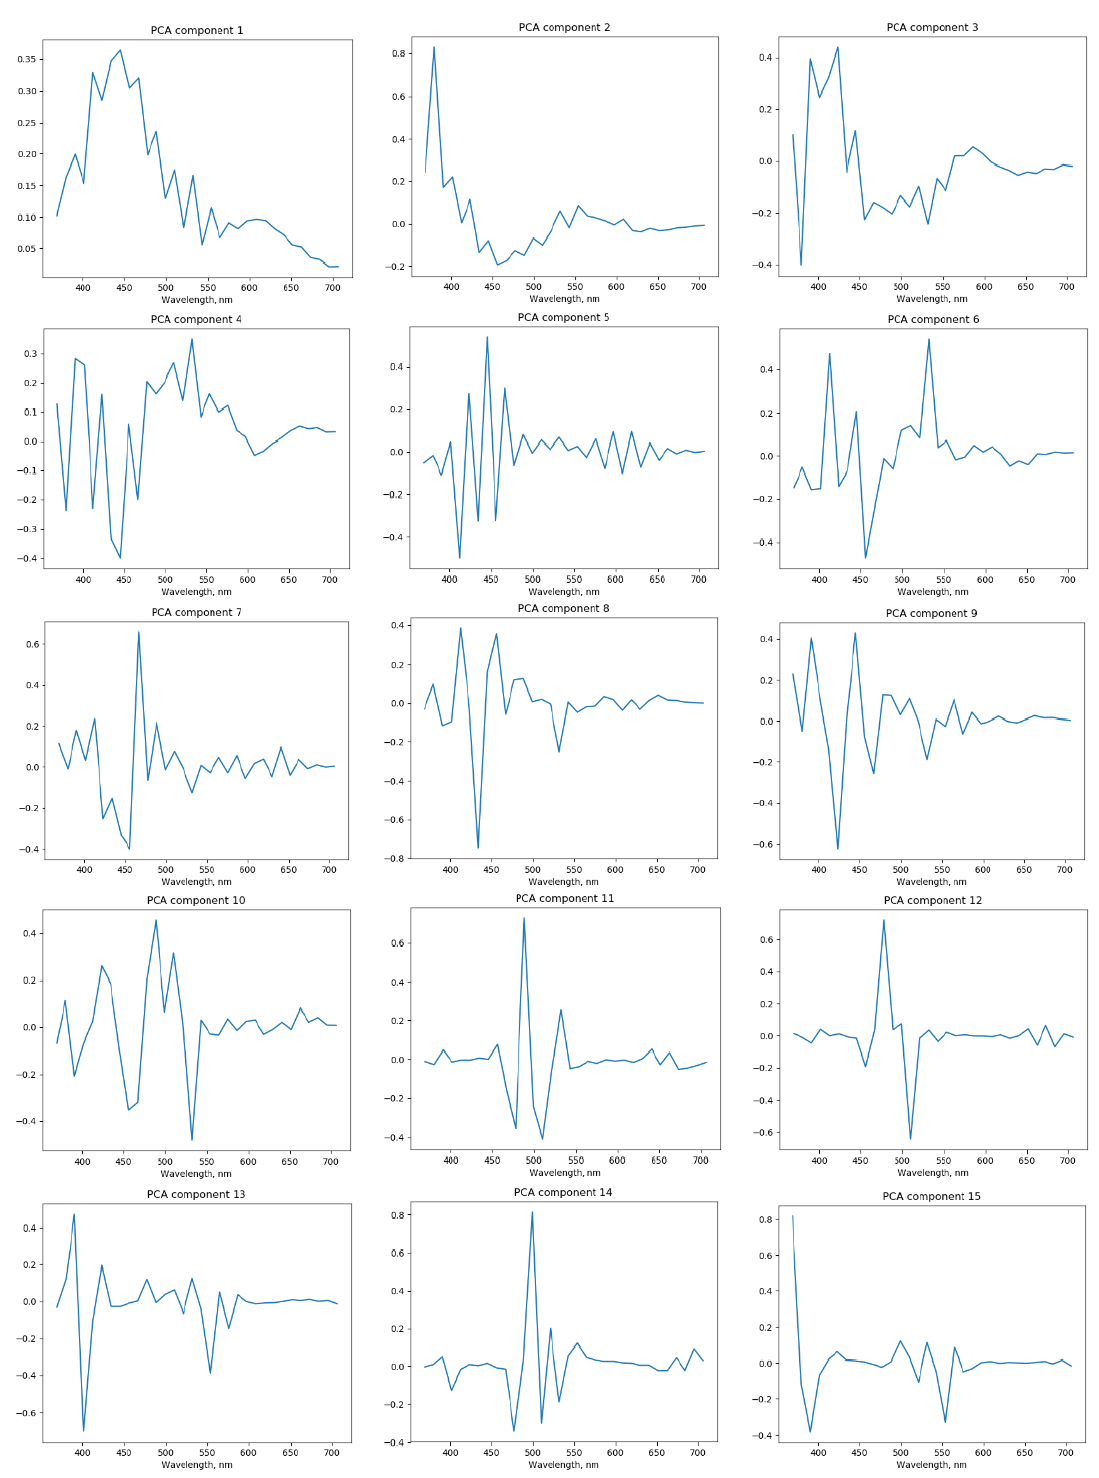
Figure 4. Principal component analysis (PCA) component variety, 15 principal components. Y axis indicates dimensionless values in interval [0–1], values at 32 wavelength forms unit length vector.